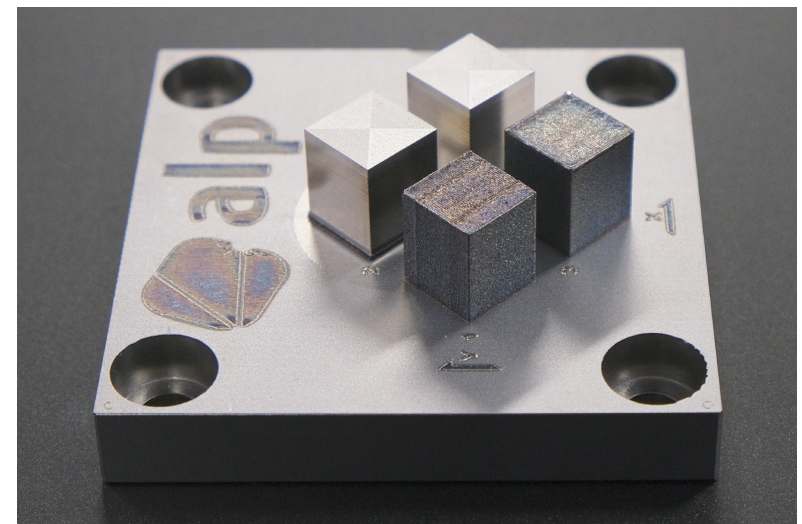
Figure 13. Image showing the optimized surfaces in comparison to the surfaces obtained with the manufacturer’s settings (back row: milled; front row: unmachined/SLM; each left: reference; on the right: optimized